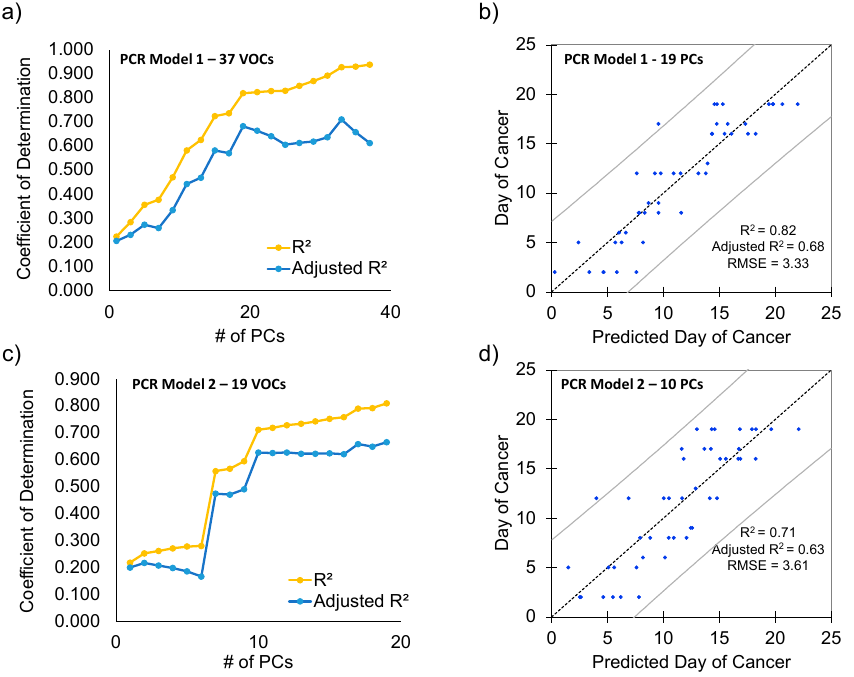
Figure 5. Principal component regression (PCR) analysis using models starting with 37 and 19 VOCs, respectively, identify leaner models in an iterative fashion. ( a ) Coefficient of determination plotted against the number of principal components utilized for the principal component regression (PCR) analysis using 37 VOCs with p -value < 0.05 (Cancer Week 1 vs. Cancer Week 3). ( b ) PCR analysis using the first 19 principal components with calculated R 2 equal to 0.82 and adjusted R 2 equal to 0.68. ( c ) Coefficient of determination plotted against the number of principal components utilized for the PCR analysis using 19 VOCs significantly contributing toward the linear correlation. ( d ) PCR analysis using the first 10 principal components results in a more stable model which could predict the number of days after tumor injection with R 2 equal to 0.71 and adjusted R 2 equal to